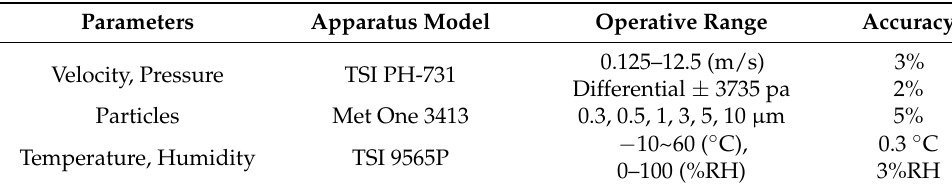
Table 1. Apparatus for field measurement tests.